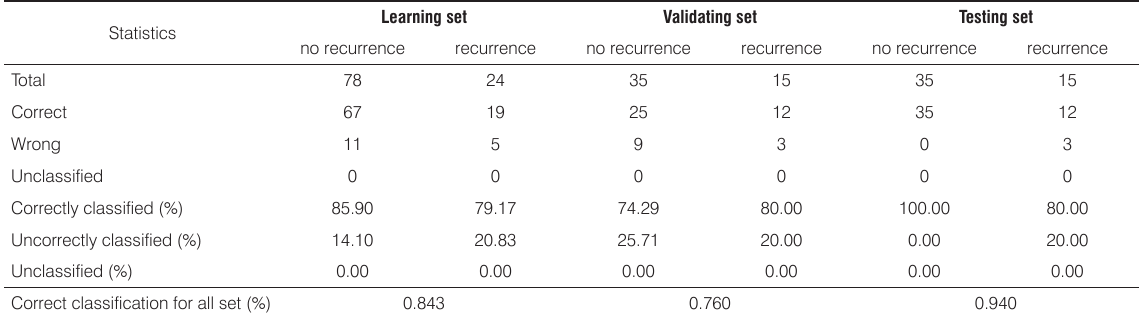
Table 3. Classification statistics for ANN model.